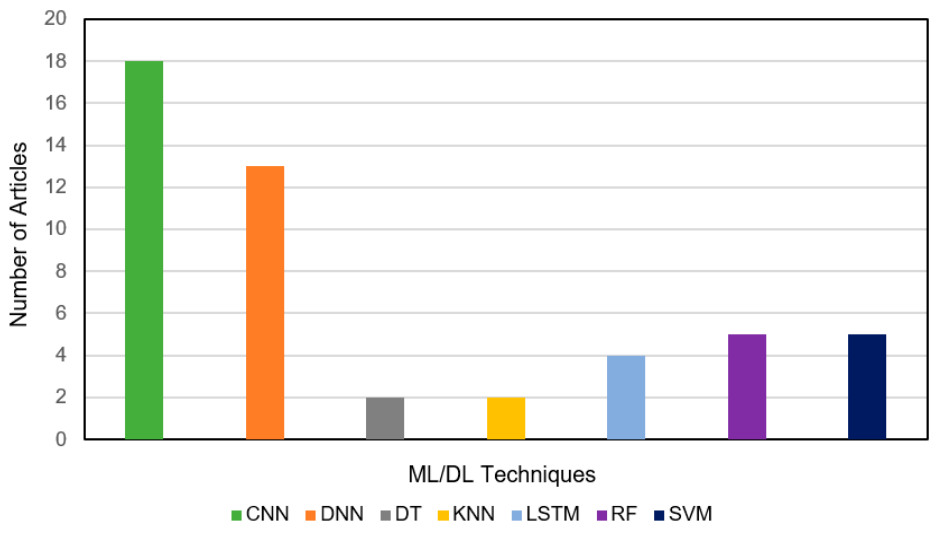
Figure 4. ML/DL techniques used in this review articles.